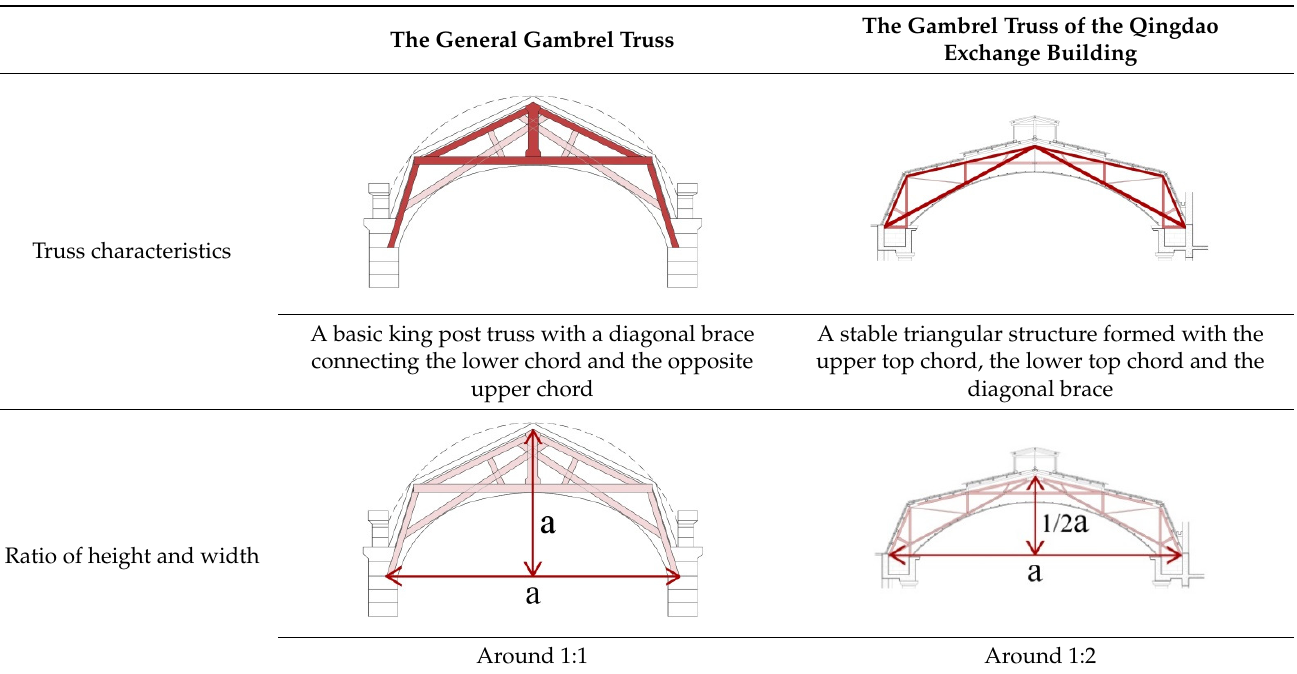
Table 2. Comparative Analysis of Gambrel Trusses.